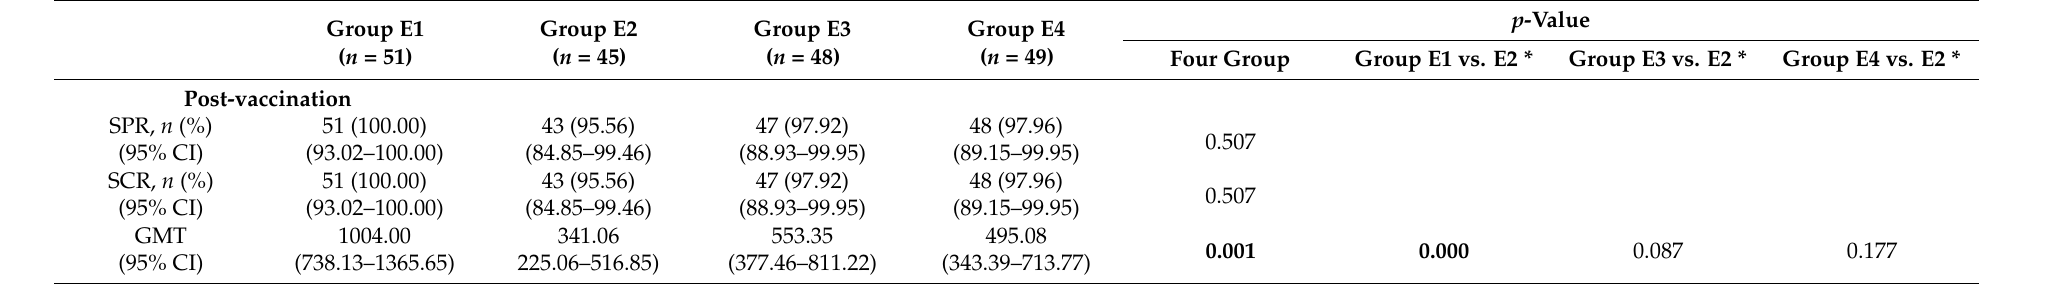
Table 3. Antibody responses to EV71 post- vaccination for group E in the per-protocol